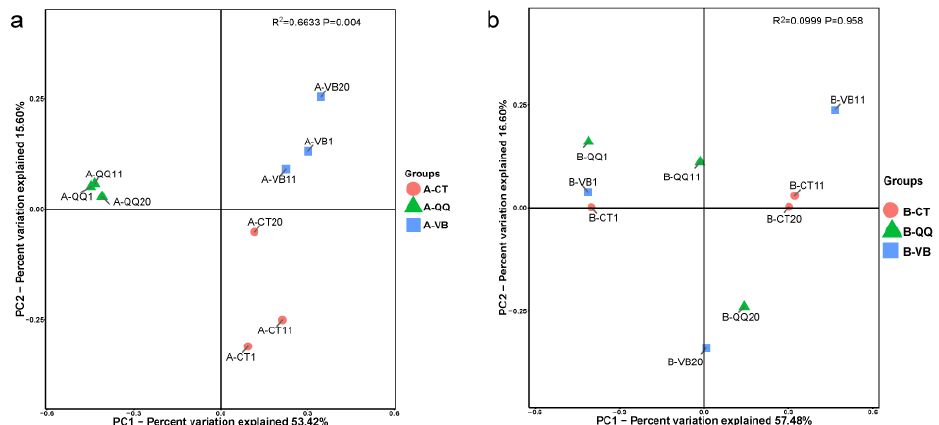
Figure 8. Principal coordinate analysis (PcoA) plot of Bray-Curtis distances. ( a ) The results demonstrated an obvious separation between samples from quorum quenching (QQ) beads (A-QQ, triangle), vacant beads (A-VB, square), and no beads (A-CT, circle); ( b ) Bray-Curtis distance metrics showed no obvious divergence between biofilms from QQ beads (B-QQ, triangle), vacant beads (B-VB, square), and no beads (B-CT, circle). Numbers 1, 11, and 20 indicate the sampling time in days.